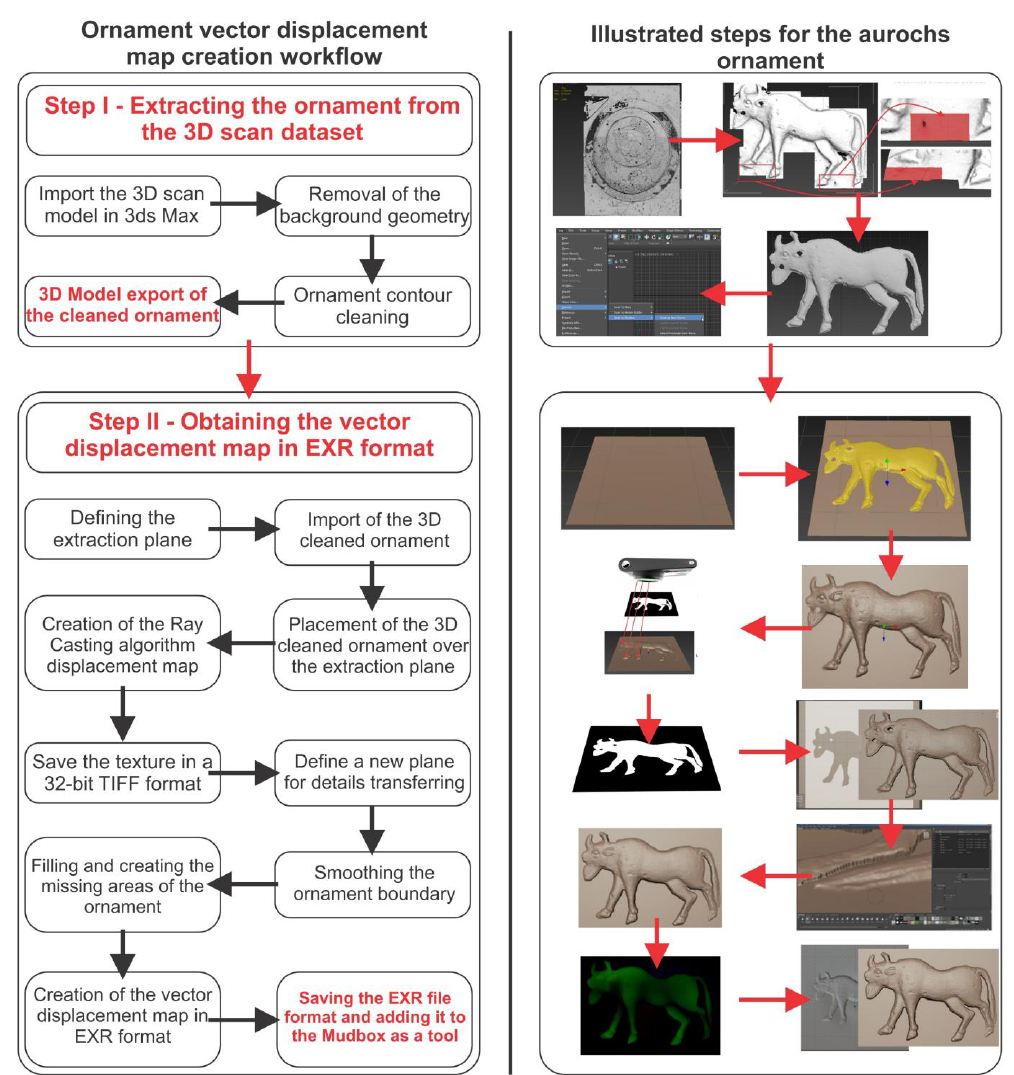
Figure 4. The proposed ornament vector displacement map creation workflow from the proposed framework, along with the illustrated steps for the aurochs ornament case study.